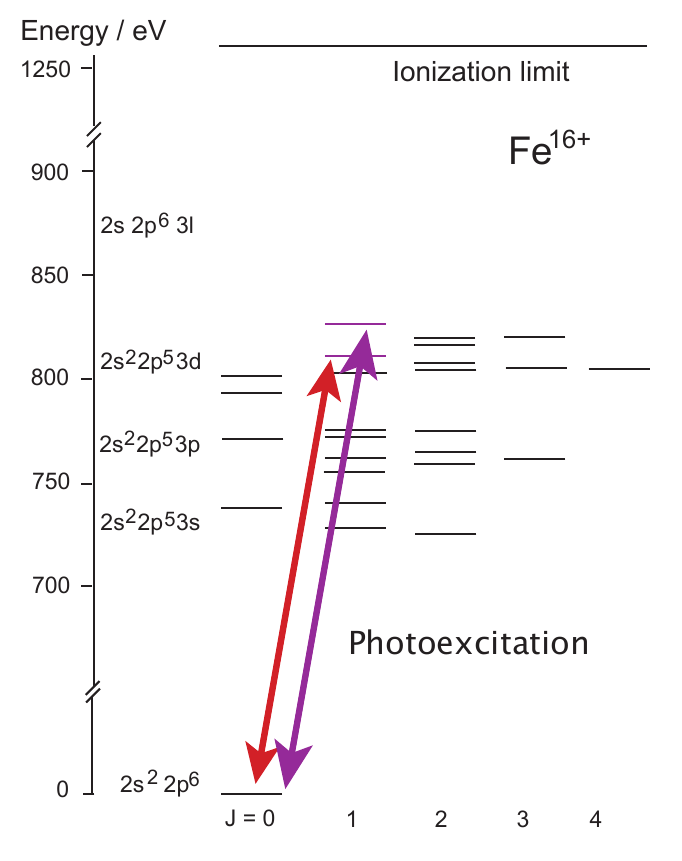
Figure 10. Level scheme of the lowest 37 levels in the Ne-like ion Fe 16+ . The two arrows point to the 2p 6 1 S – 2p 5 3d 1 P o , 3 D o transitions discussed in the text and illustrate 0 1 1